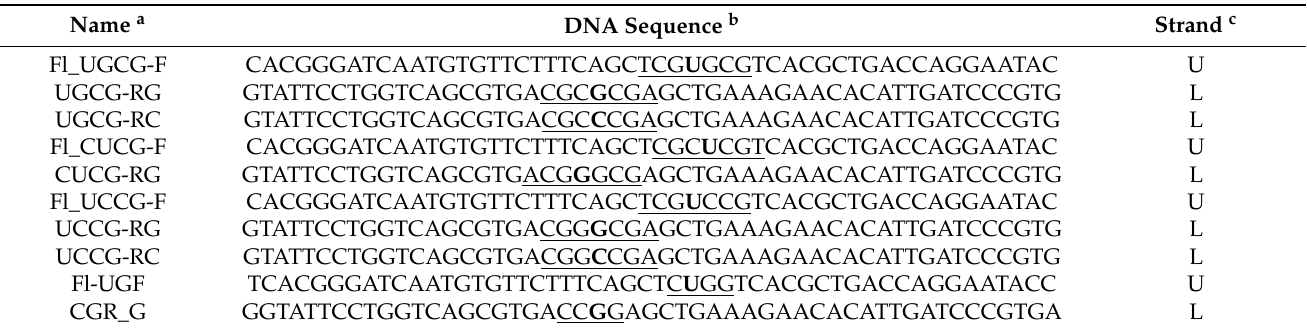
Table 1. Oligonucleotides used as